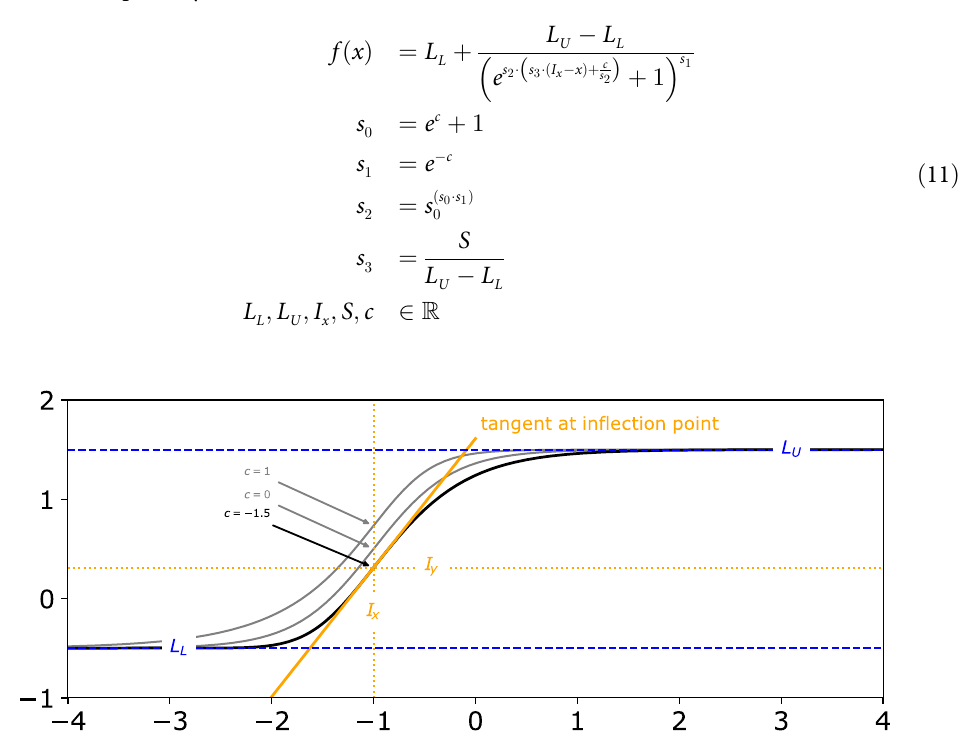
Fig 5. Reparametrized asymmetric logistic function. When parametrized as shown in Eq 11, each of the 5 parameters can be manipulated without influencing the others. Note that, for example, the symmetry parameter c can be changed without affecting the x-coordinate of the inflection point ( I x ), or the slope S at the inflection point (gray vs.